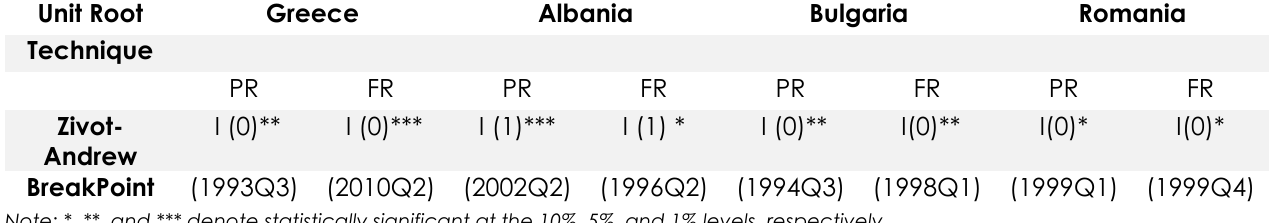
Table 2: Summary of Unit Root Test outcomes. Unit